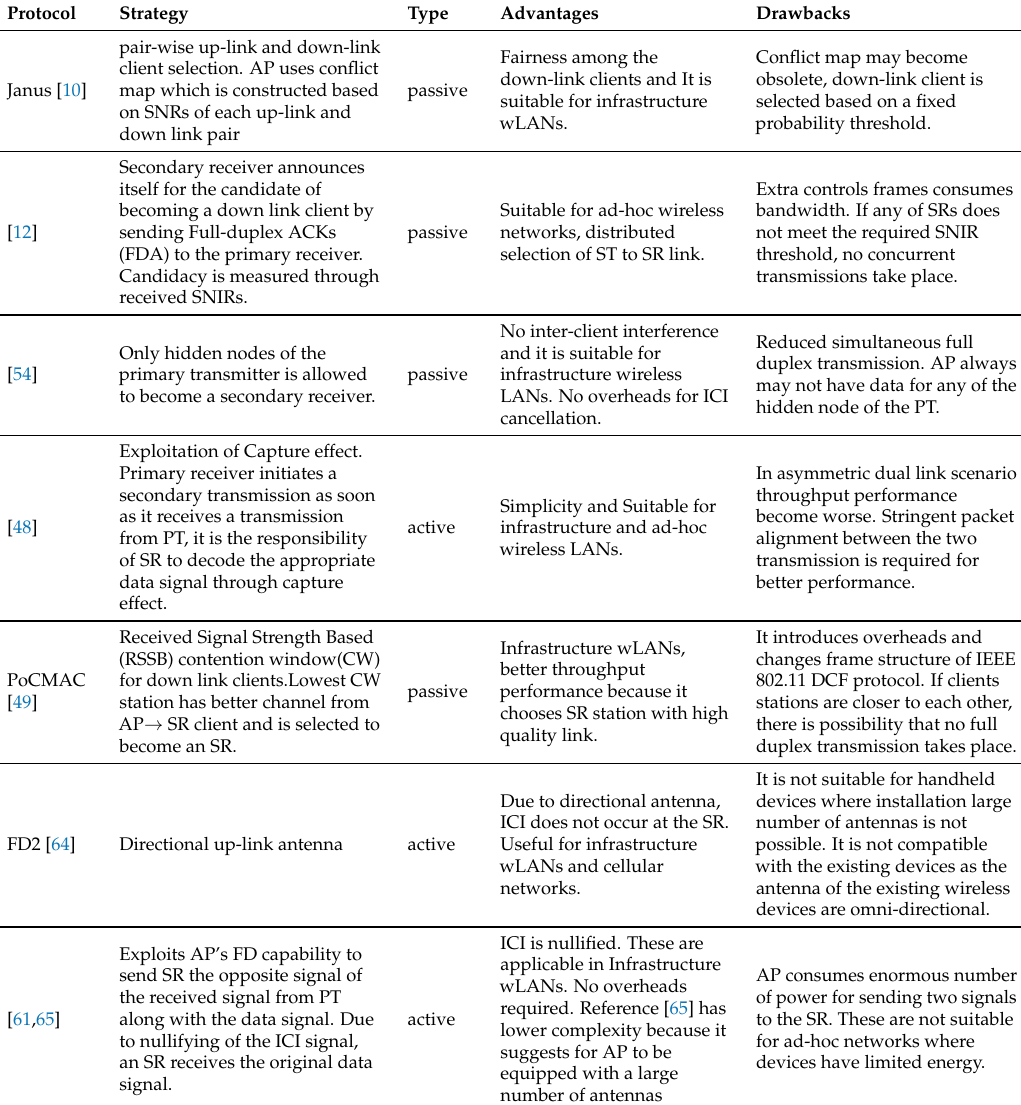
Table 5. Comparisons among various solutions of inter-client interference cancellation in full duplex MAC protocols and their